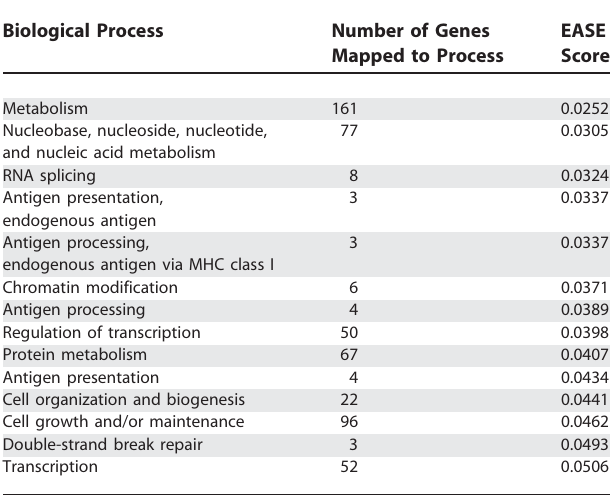
Table 5. Identification of Global Changes in Gene Expression in HCAEC Following Treatment with 2 l M ADMA Biological Process